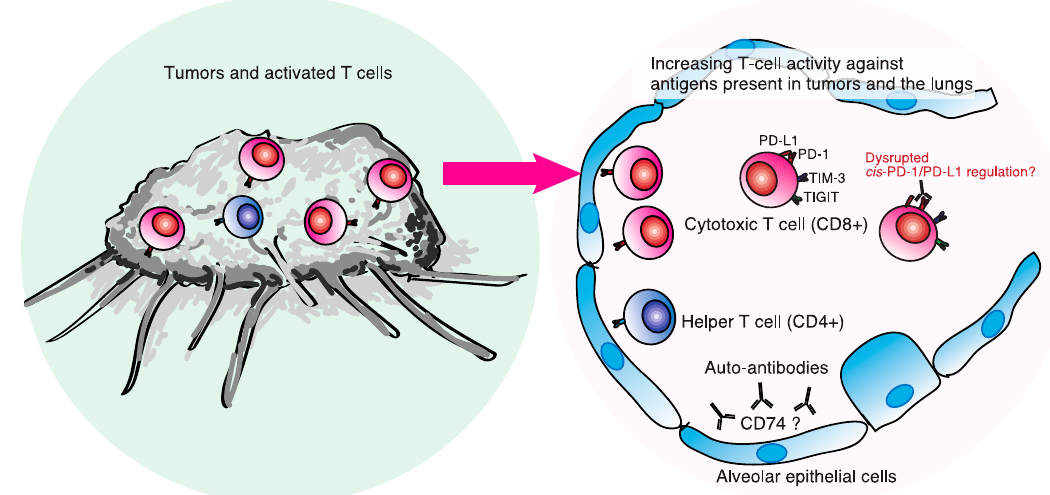
Figure 1. Possible pathobiological mechanisms underlying immune-checkpoint inhibitor-related pneumonitis. Cellular immunity mediated by T cells is thought to be highly involved. T-cell-dominated lymphocytosis is present in BALF from ICI-pneumonitis. CD8+ T cells in BALF express immune-checkpoint proteins (PD-1+TIM-3+), characteristic of tumor-infiltrating T lymphocytes. A substantial number of T cell clones in BALF were identical with T cells in the peritumoral lesion. These facts support the hypothesis that ICI-pneumonitis may be induced by ICI-activated T cells recognizing self-peptides or shared epitopes between tumors and the lungs. Moreover, the proportion of PD-1+PD-L1+ cells among CD8+ T cells in BALF was correlated with the severity of ICI-pneumonitis by anti-PD-1 therapies, suggesting that the disruption of cis-PD-1/PD-L1 regulation by anti-PD-1/PD-L1 therapies can induce aberrant activation of self-reacting T cells, resulting in severe ICI-pneumonitis. Autoantibodies such as anti-CD74 antibodies may also be involved in the pathogenesis of ICI- pneumonitis.